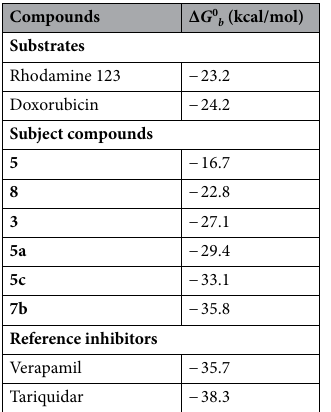
Table 2. Free energies of binding from the MMPBSA analyses of the MD